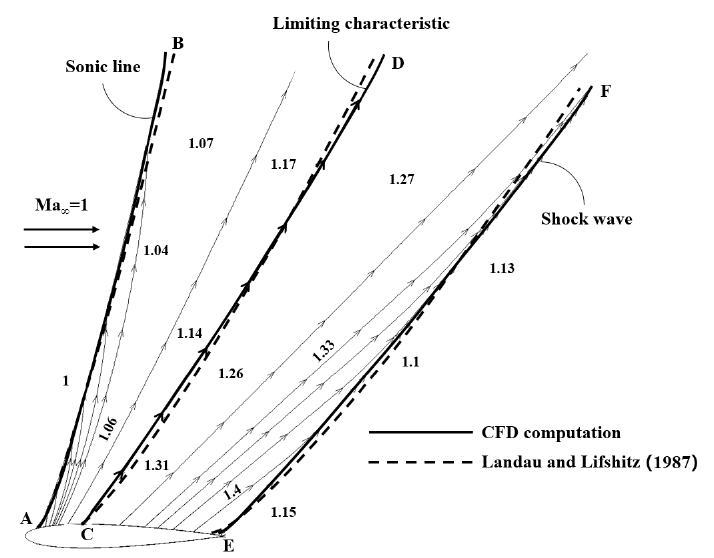
Figure 4. Limiting Characteristics in the Mach number contour map [12].